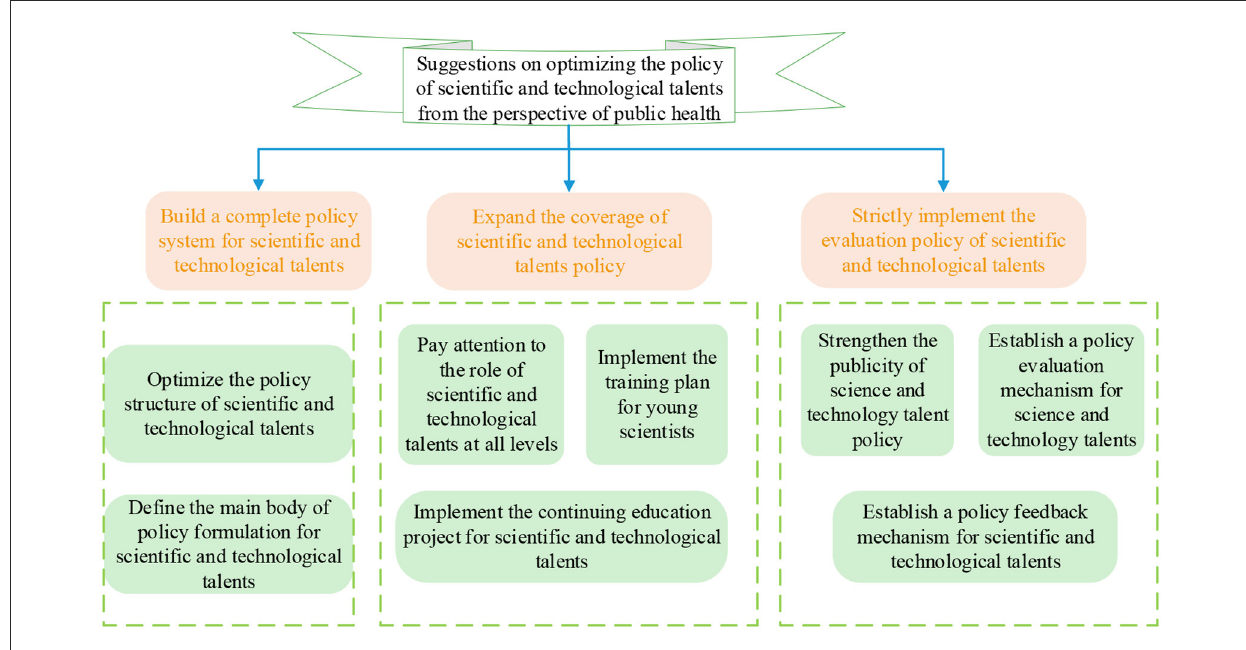
FIGURE6 The suggestions for optimizing the S&T talents policy.